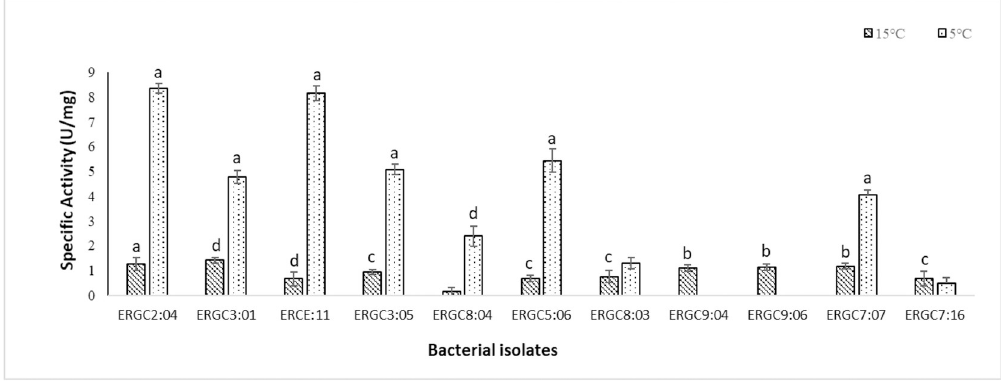
Fig 5. Protease activities of 11 Pseudomonas strains at 5˚C and 15˚C, with casein as substrate. Error bars denote the standard deviation of the mean of the three biological replicates (n = 3). Letters a, b, c, d denote significant differences between the reaction control and reaction test at p < 0.0001, p < 0.0002, p < 0.0003, p < 0.0004, respectively, using one-way ANOVA by Dunnett’s multiple comparison test (No letter = non-significant